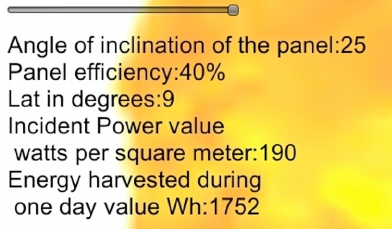
Figure 4. Output from augmented virtuality solar energy